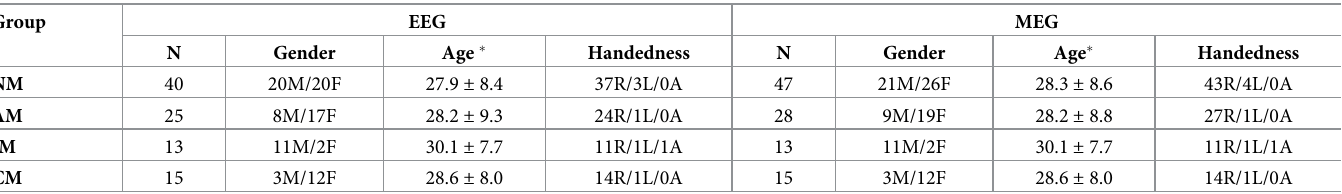
Table 2. Demographic data of subjects.